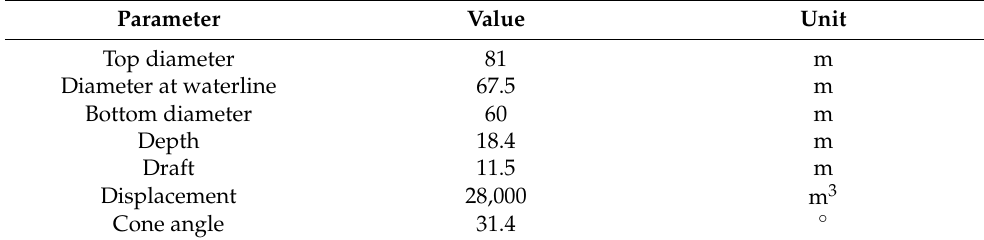
Figure 8. Numerical computation model of Kulluk platform. ( a ) Front view of the model; ( b ) stere- ogram of the model. Table 6. Basic parameters of the Kulluk platform.